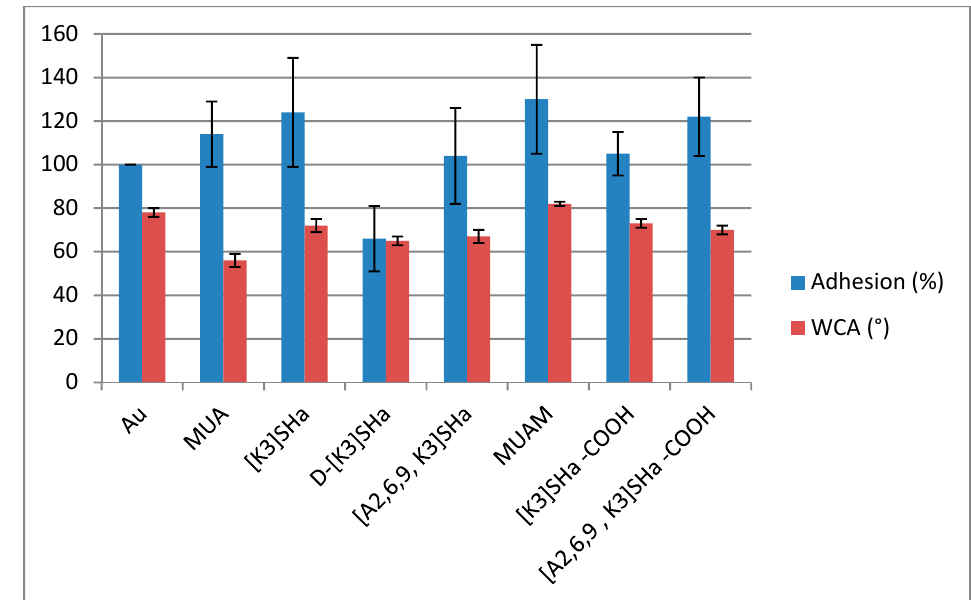
Figure 6. L. ivanovii bacterial adhesion (%) compared to gold bare substrate (100%), left bars. Water contact angle, WCA (°) measured on Au and modified surfaces, right bars.